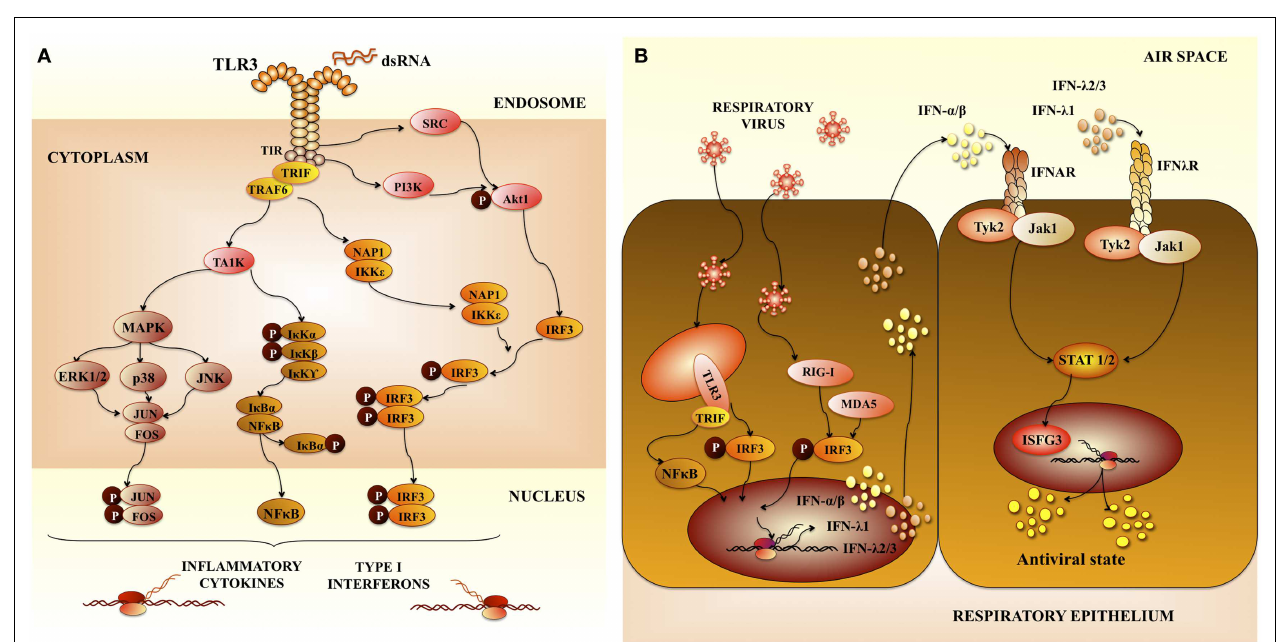
genes involved in inflammatory responses. (B) Anti-viral immune response in airway epithelial cells mediated by pattern recognition receptors and